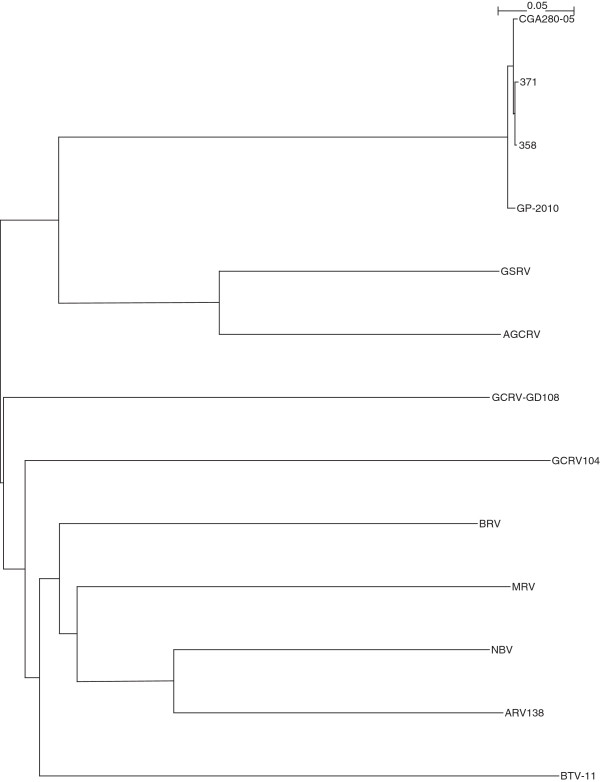
Phylogeny of homologous segment S2 shared by piscine reovirus (PRV) and selected members of familyReoviridae.